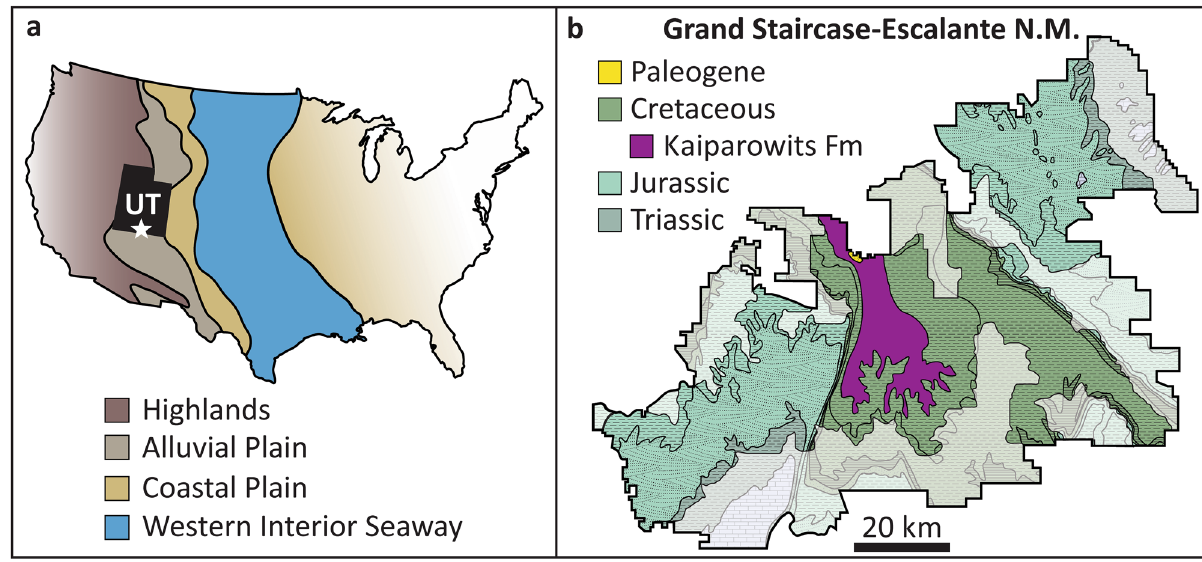
Figure 1. ( a ) Paleogeography of the United States during the Campanian (after Roberts and Kirschbaum, 1995 17 ; image generated with Adobe Illustrator CS4, version 14.0.0—see https:// www. adobe. com/ produ cts/ illus trator. html for recent versions). Star denotes location of Grand Staircase-Escalante National Monument. ( b ) Geologic map of GSENM with Cretaceous Kaiparowits Formation highlighted (after Foster et al. 1 ; image generated with Adobe Illustrator CS4, version 14.0.0—see https:// www. adobe. com/ produ cts/ illus trator. html for recent versions). Areas shaded white indicate areas of the monument lost to the 2017 boundary modifications of White House Proclamation